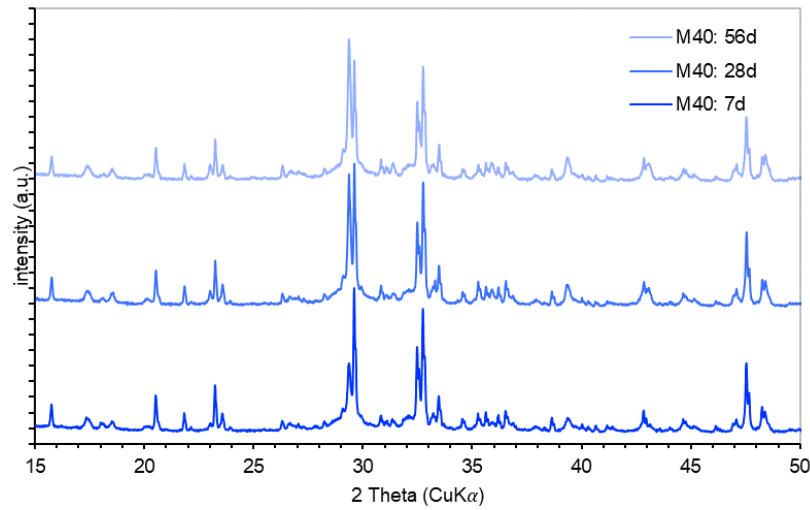
Figure 9 . XRD patterns of alkali-activated slag at 40 °C and different curing times.